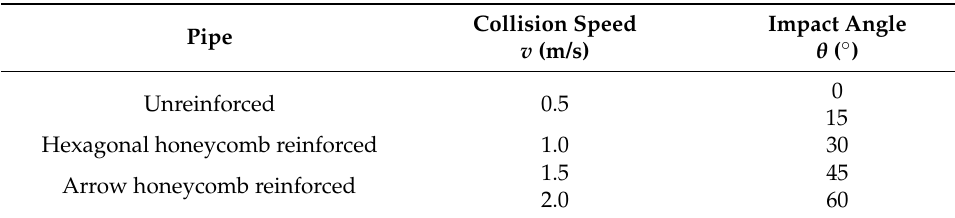
Table 5. Collision scenarios setting.